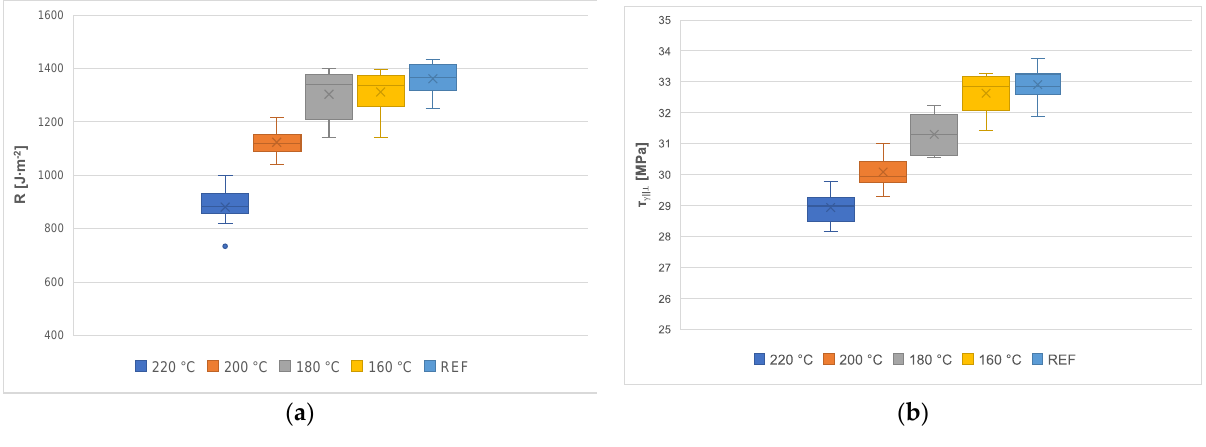
Figure 7. ( a ) Fracture toughness, ( b ) shear yield strength.